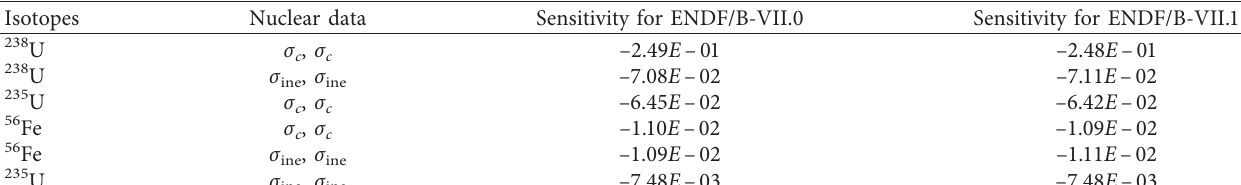
Table 3: Major sensitivities of k